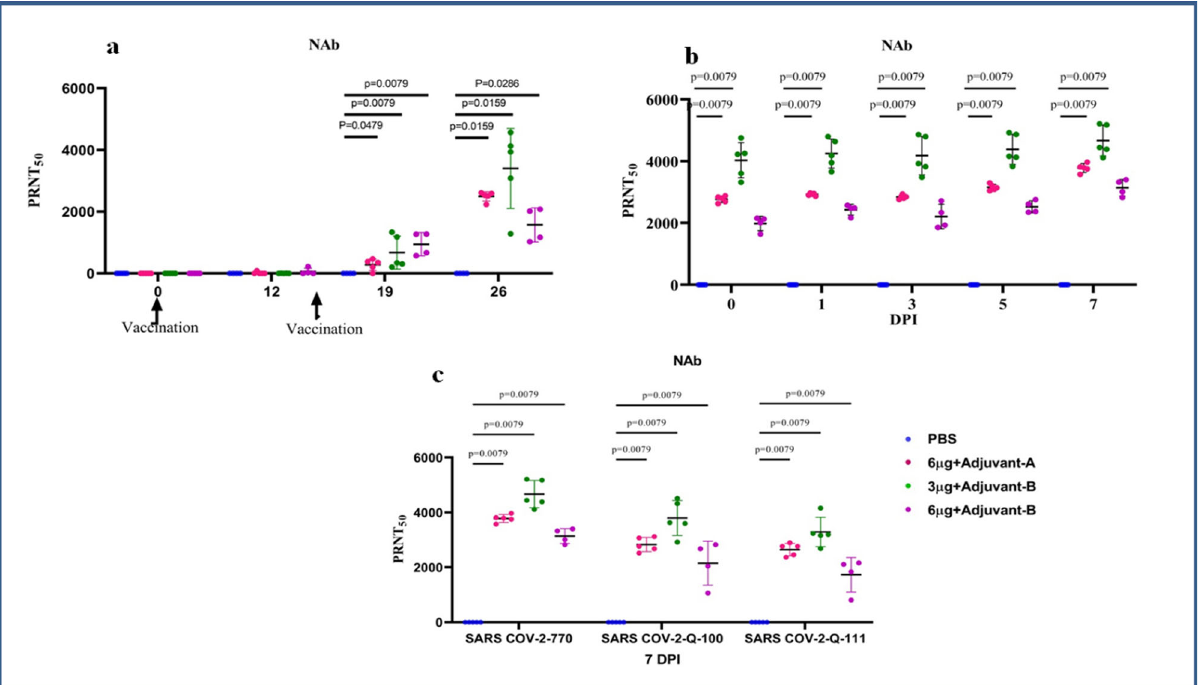
Fig. 2 NAb response in vaccinated animals. a NAb titres in animals from 1st to 4th week of immunisation. b NAb titres in animals at 0, 1, 3, 5 and 7 DPI. c NAb titres in animal samples of 7 DPI with homologous strain 770 and heterologous strain Q-100 and Q-111 of SARS-CoV-2. The statistical signi fi cance was assessed using the Kruskal – Wallis test followed by the two-tailed Mann – Whitney test between two groups; P values of < 0.05 were considered to be statistically signi fi cant. Data are presented as mean values + / − standard deviation (SD). Statistical comparison was done by comparing the vaccinated group with the placebo group as a control. Group I = blue, group II = pink, group III = green and group IV = purple, number of animals = 5 animals in each group. Source data are provided as a Source Data fi